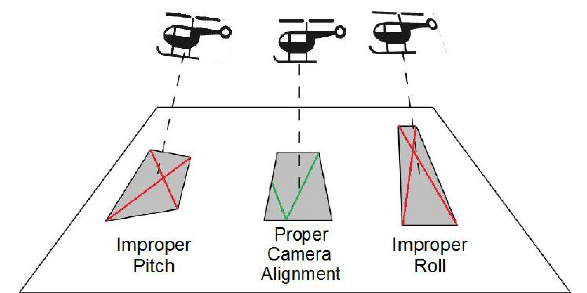
Figure 4: Ground imaging areas of proper and improper heli ori-